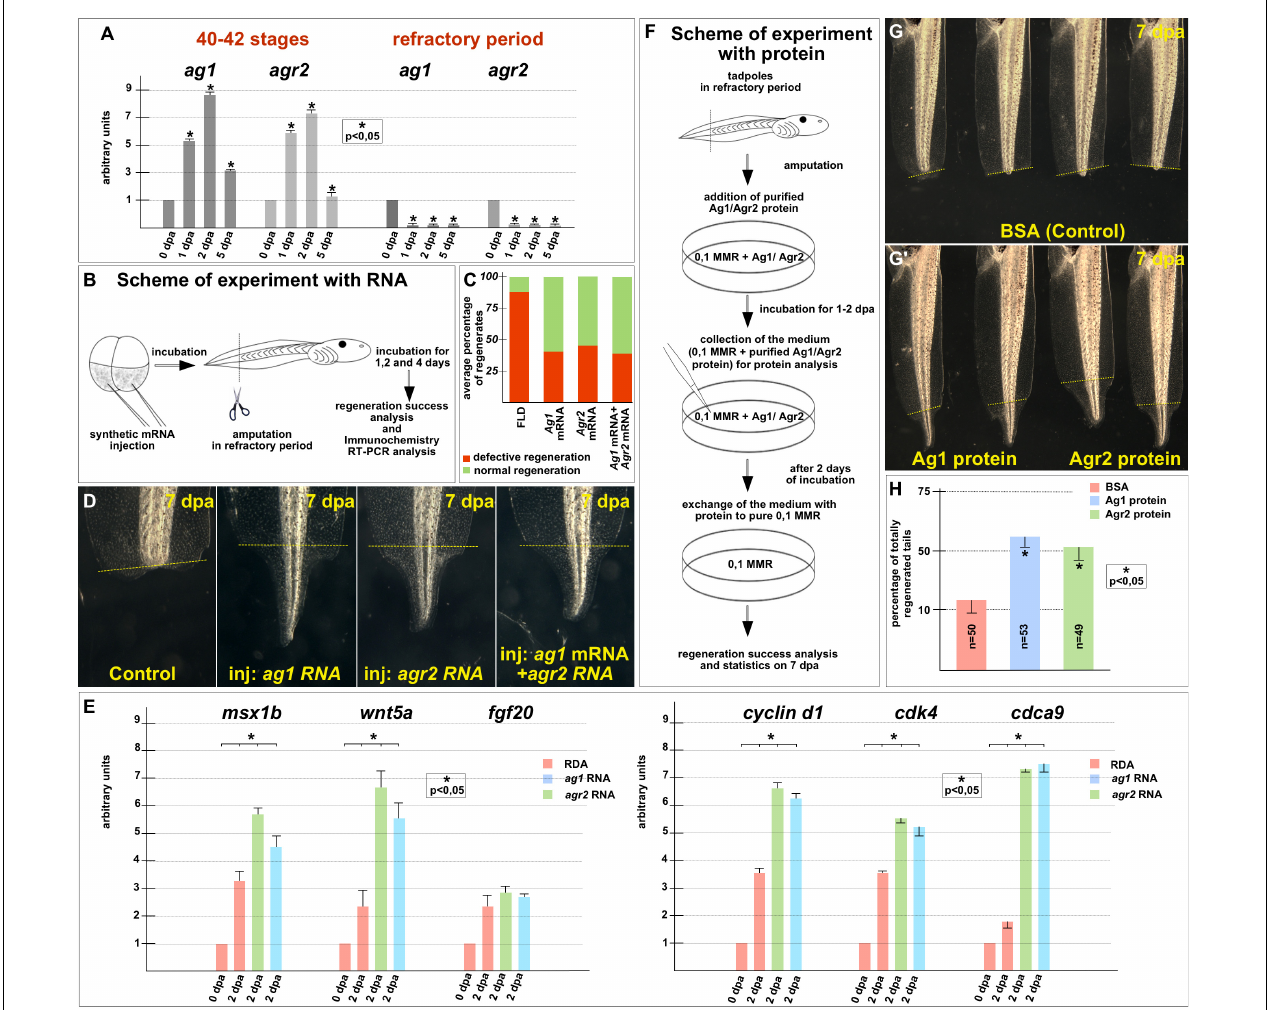
FIGURE 4 | Regeneration blockage during tadpoles’ refractory period can be unlocked by ag1/agr2 over-expression or incubation in solution with purified Ag1/Agr2 proteins. (A) The qRT-PCR results show the difference in expression dynamics of ag1 and agr2 at 0–5 dpa in tadpole regenerates upon amputation at stage 40–42 or in the refractory period. The value of normalized PCR signal in the 0 dpa sample, harvested immediately after amputation, was taken as an arbitrary unit in each series. Dpa—days post amputation. Error bars indicate SD, t -test, p < 0.05 (asterisk). (B) Scheme of the experiment with ag1/agr2 over-expression and types of analysis of the regeneration process in the refractory period. (C) Statistical analysis of regeneration success of tadpoles, developed from embryos injected with a solution of FLD, either ag1 or agr2 mRNA (or both), and amputated in the refractory period. The picture shows the average values. (D) The transmitted light images of tails of corresponding tadpoles on 7 day post amputation in the refractory period demonstrate total regeneration of tails in tadpoles over-expressing either ag1 or agr2 mRNA (or both). (E) qRT-PCR analysis of expression levels changes of regeneration markers msx1b , wnt5a, and fgf20 and cell cycle markers cyclin d1 , cdk4 and cdca9 during the regeneration process (at 0 and 2 dpa) in amputated tails of tadpoles injected with RDA, ag1 or agr2 mRNA solution. The value of normalized PCR signal in the 0 dpa sample, harvested immediately after amputation, was taken as an arbitrary unit in each series. Dpa—days post amputation. Error bars indicate SD, t -test, p < 0.05 (asterisk). (F) Scheme of the experiment with tadpoles amputated in refractory period and incubated in solution with BSA, Ag1 or Agr2 purified proteins (see Supplementary Material for the procedure of the recombinant proteins preparation and Supplementary Figure 3B for testing the integrity of the proteins in the medium with tadpoles). (G,G’) The transmitted light images of tadpoles tails on day 7 post amputation in the refractory period after incubation in BSA solution (G) or in solution with Ag1 or Agr2 proteins (G’) demonstrate total regeneration only in the latter variants. (H) Statistics of normally regenerated tails percentage among tadpoles amputated in refractory period and incubated with BSA or purified Ag1 or Agr2 proteins. N—total number of tadpoles used in three independent